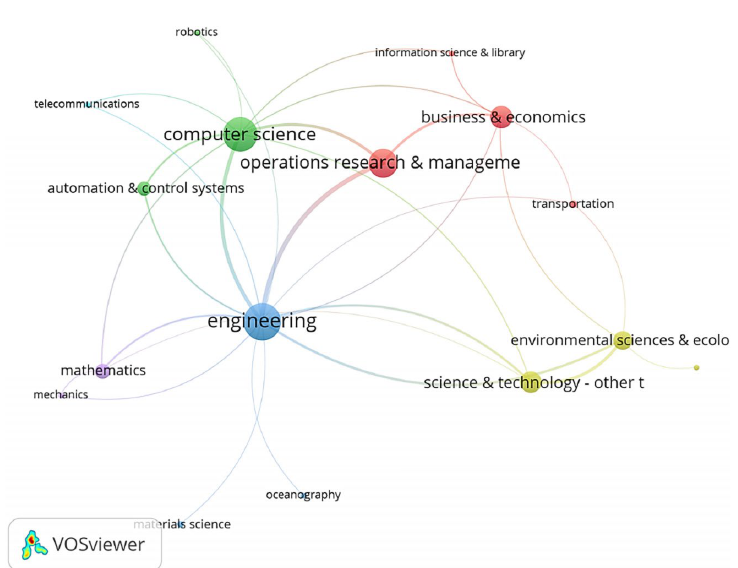
Figure 2. Publication volume and connections of